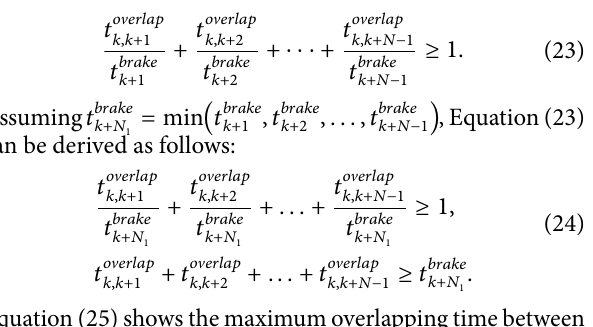
Figure 6: The diagram of regenerative braking energy utilization of train 𝑘